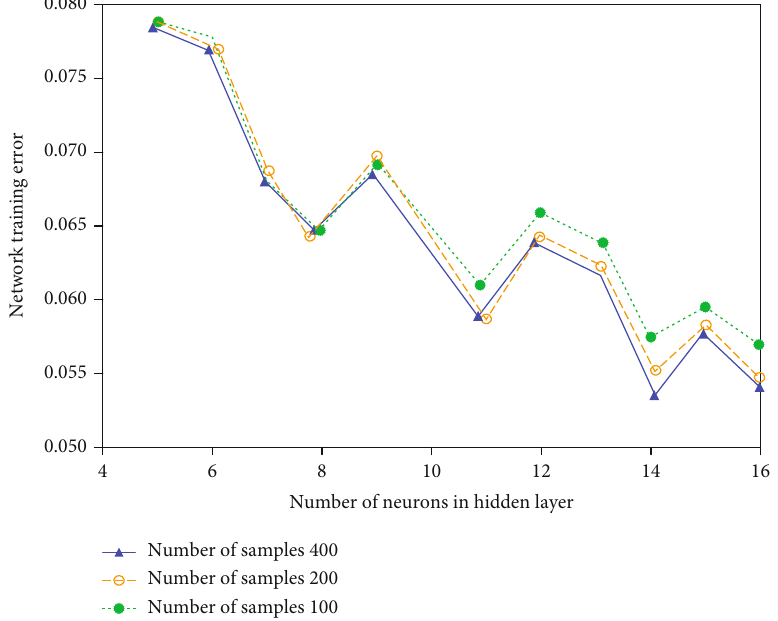
Figure 5: Network training error corresponding to the number of hidden layers.